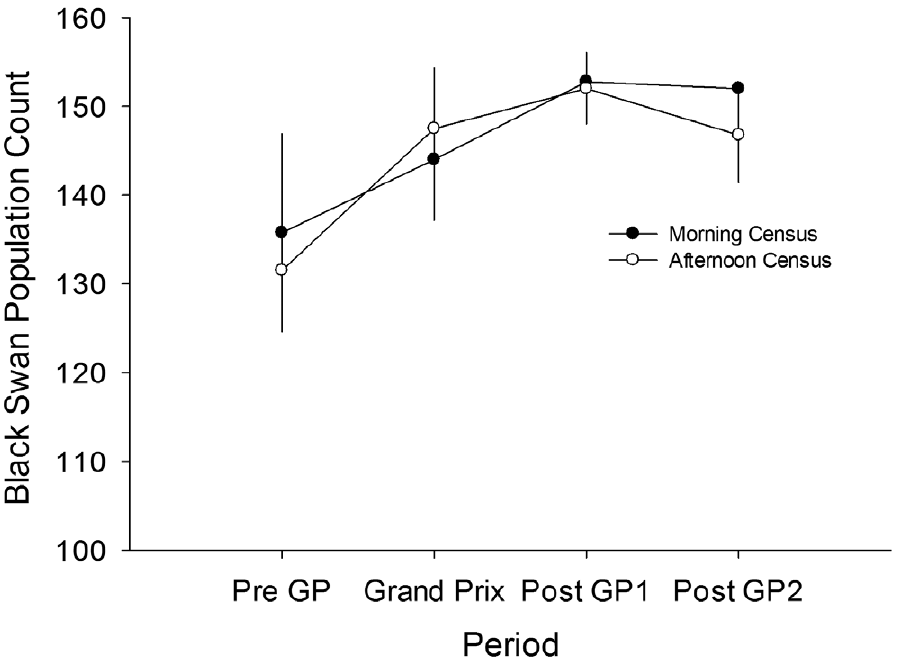
Figure 2. Population counts (mean 6 SEM) of black swans at Albert Park over the experimental period (n=8 for all periods). Closed circles represent morning counts and open circles represent afternoon counts.